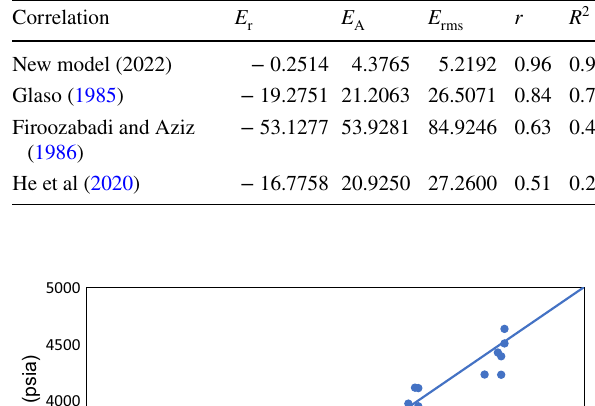
Table 4 Statistical analysis for predicted MMP (training set) Correlation